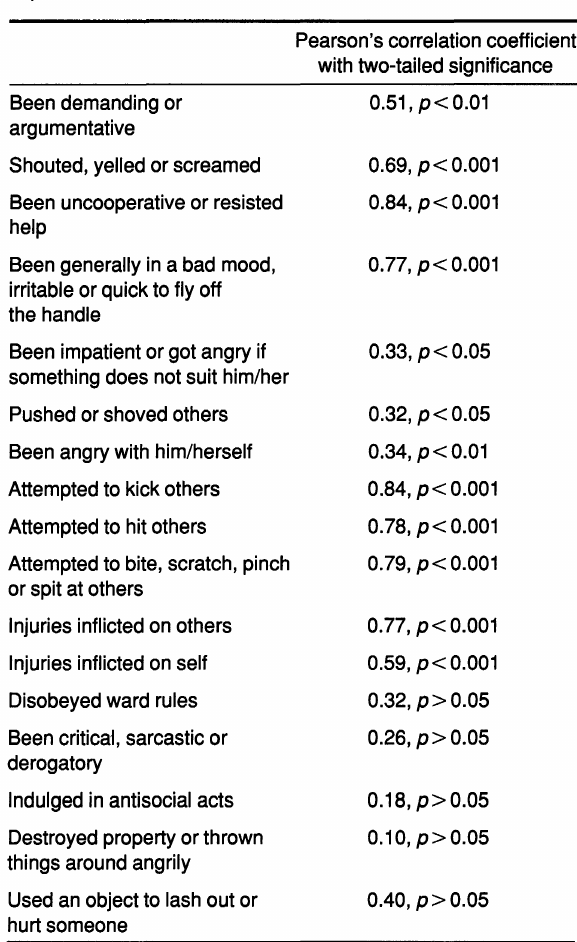
TABLE II. Correlation of individual items with the overall global